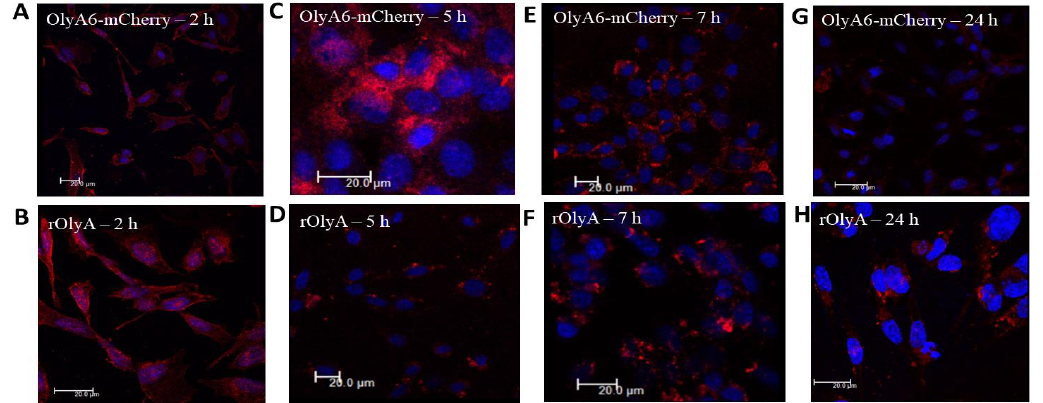
Figure 3. Intracellular distribution of rOlyA and OlyA6-mCherry at different time points: 2 h ( A , B ), 5 h ( C , D ), 7 h ( E , F ) and 24 h ( G , H ) in fixed HIB-1B preadipocytes. Representative images of immunofluorescence using antibodies against rOlyA (10 µg mL −1 ) immunostained with Alexa Fluor 594 or OlyA6-mCherry (30 µg mL −1 ) mCherry (610 nm). Fixed HIB-1B cells were incubated with rOlyA or OlyA6-mCherry, followed by treatment with anti-rOlyA antibodies and the secondary antibodies conjugated with Alexa Fluor 594. Scale bar = 20 µ m.